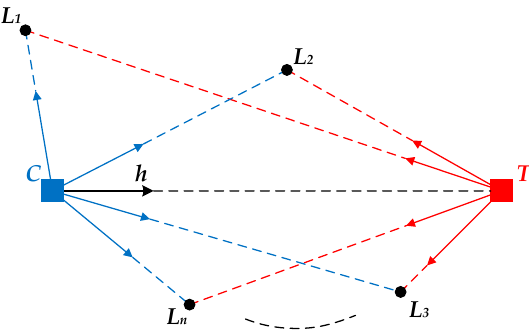
Figure 1. The ALV model. The blue square represents the current location. The red square represents the target location. The black circles represent the extracted landmarks. The blue and red arrows stand for the corresponding landmark vectors. The desired homing vector is denoted as the black arrow.